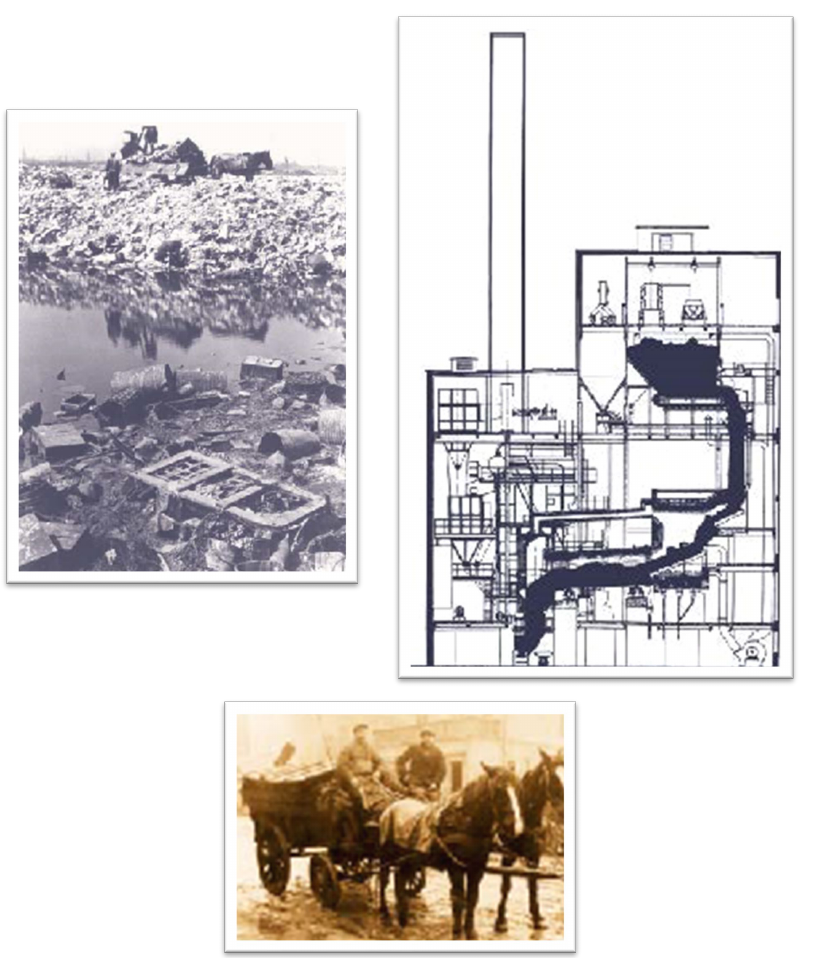
Figure 2. Top left: landfill and waste management challenges. Top right: sectional drawing of Aarhus incineration plant. Bottom: horse-drawn garbage wagon. Source: [38]. 3.2. Post-WWII: The Emergent Welfare State, Cooperative Values, and Favorable Financing Decreased fossil fuel imports during WWII led to an energy crisis in Denmark, and the German occupation of the country from the year 1940 effectively stopped further ex- pansion of the district heating networks [4,34,39,40]. Fuel was in short supply, it was